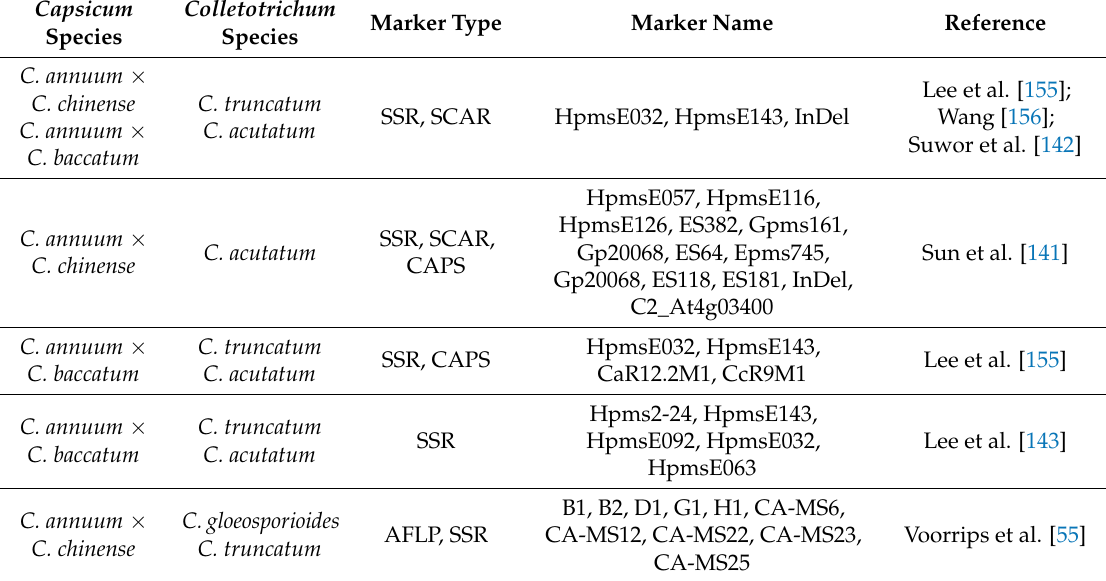
Table 2. Molecular Markers Associated with Anthracnose-Resistant Traits in Capsicum, with Marker-Assisted Selection